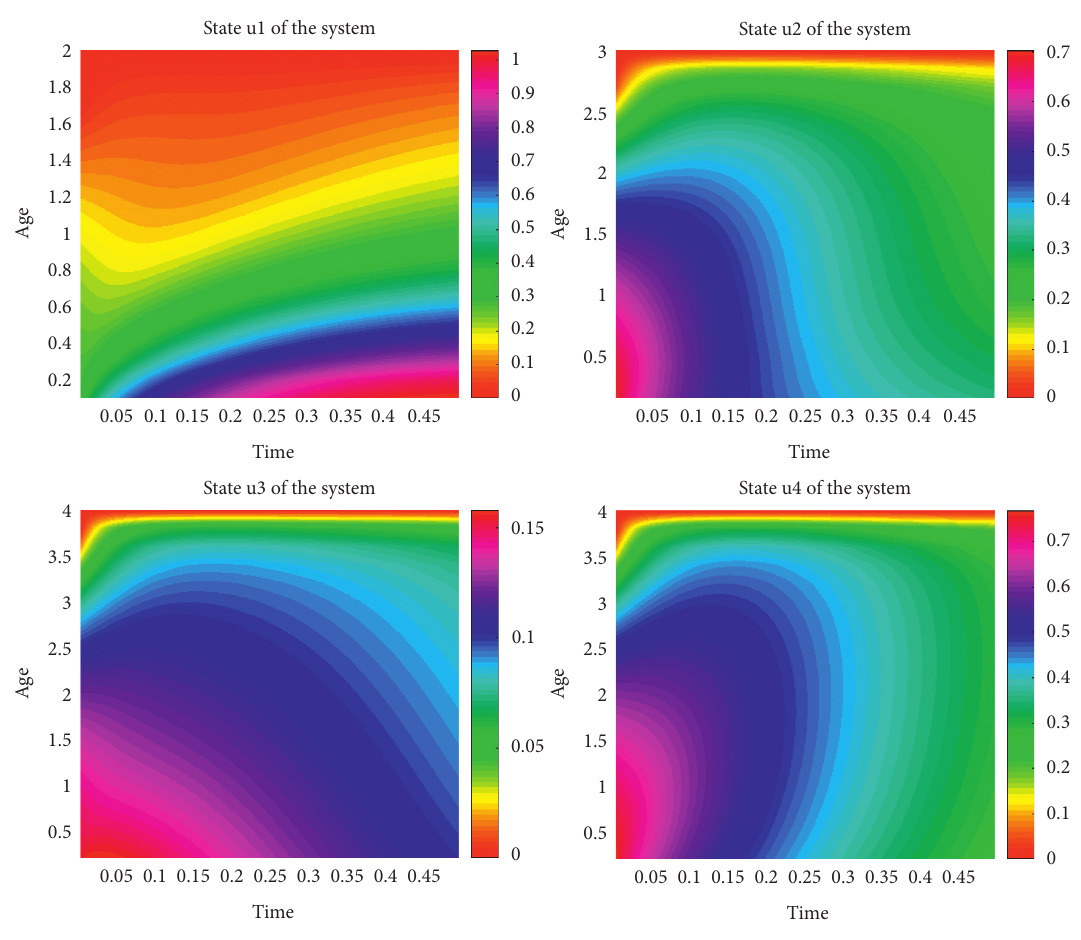
Figure 2: Uncontrolled solution at final time T � 0 . 5 and A �